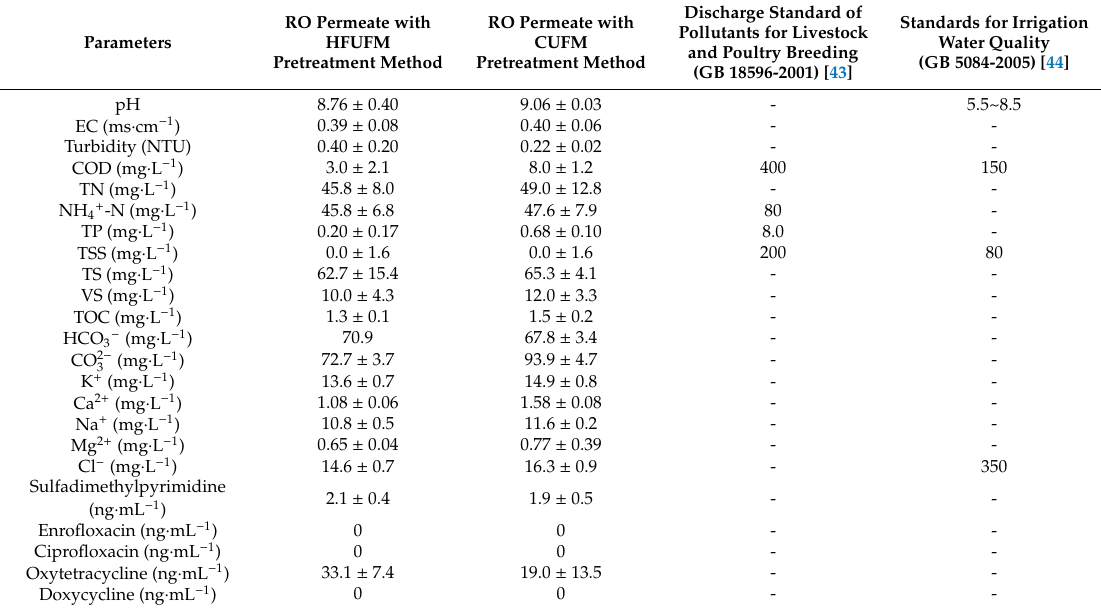
Table 5. The physicochemical properties of the RO permeate from the biogas digestate treated using the NF + RO processes with HFUFM and CUFM (mean ±